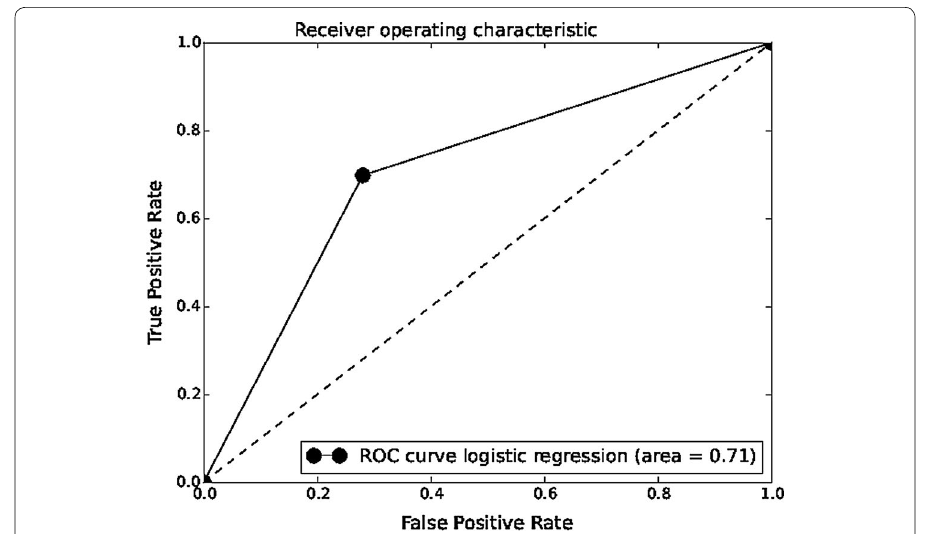
Fig. 1 Receiver operating characteristic for logistic